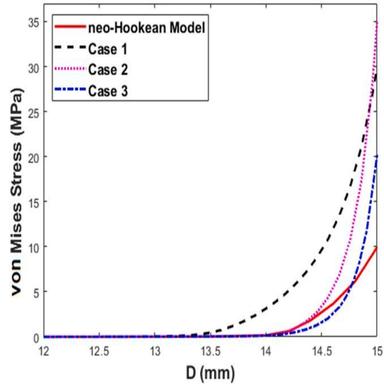
Influence of material nonlinearity in the IPP expansion simulation (scenario I and point 3 (Mid_TA)).